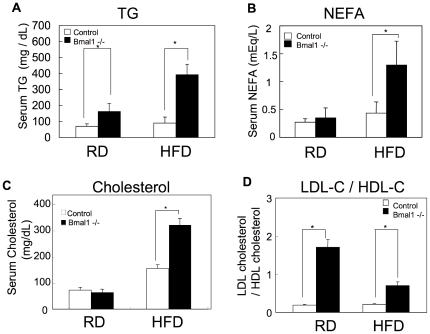
Alteration of circulating fatty acids level in Bmal1 -/- mice.Serum samples were prepared from male mice fed a regular diet (RD) or a high-fat diet (HFD) for 5 weeks. All samples were collected at ZT 10. (A) Triglycerides (TG). (B) Non-esterified fatty acids (NEFA). (C) Total cholesterol. Data represent the means ± SEM (n = 8 for each genotype and treatment). Asterisks indicate significant differences (P<0.05). (D) The LDL cholesterol/HDL cholesterol ratio was calculated based on the data shown in Table 1. Data represent the means ± SEM (n = 8 for each genotype and treatment). Asterisks indicate significant differences (P<0.05).